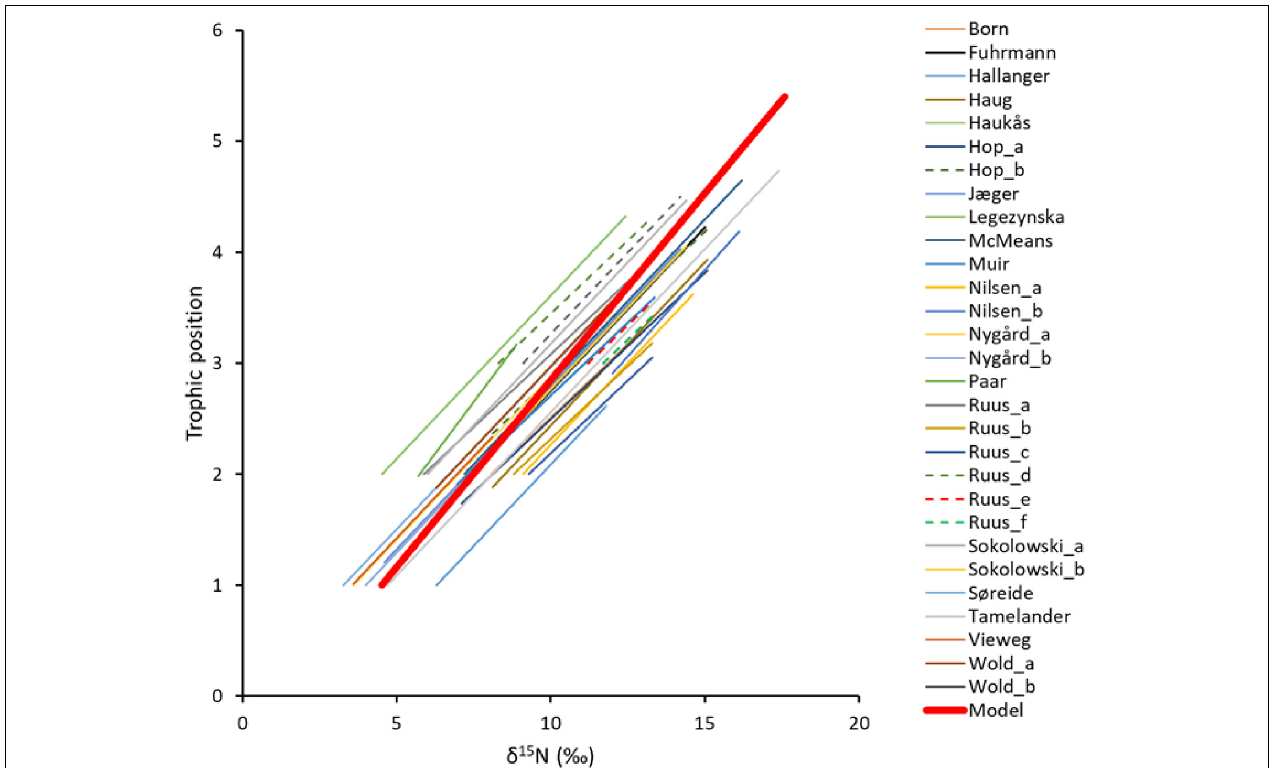
FIGURE 4 | Comparison of 29 published linear relationships between trophic positions (TP) and δ 15 N values from literature from the Barents Sea Large Marine Ecosystem. Red bold line show the linear best-fit model for the TP- δ 15 N value relationship estimated in this study for all habitats. The linear best-fit relationship had a δ 15 N base value of